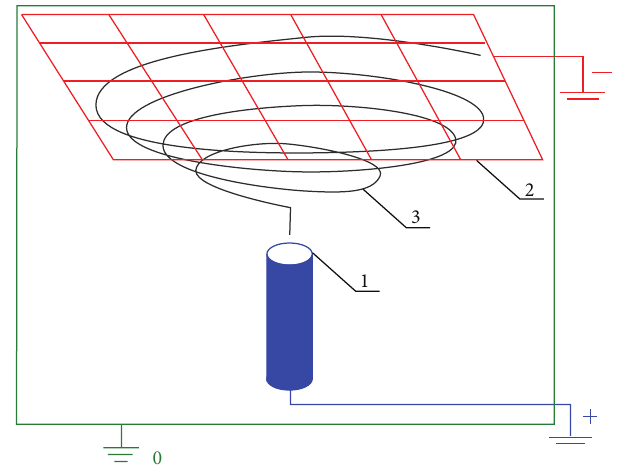
Figure 1: Vertical configuration of the DC based electrospinning setup: the nanofibers (3) created at the positively charged electrode (1) are collected on the oppositely charged electrode (2) inside a device frame with zero